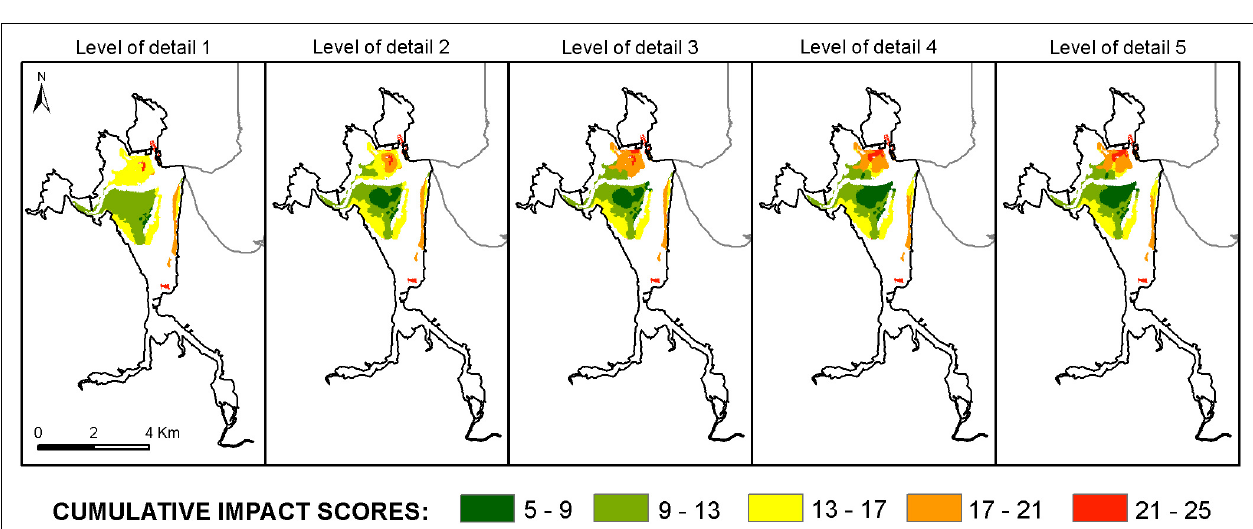
FIGURE 5 | Spatial distribution of the ecotopes of Zostera noltei in the Santoña estuary at five scales (4, 8, 17, 25 y 28 ecotopes from level 1 to level 5, respectively). Different colors represent different ecotopes within each level of detail.